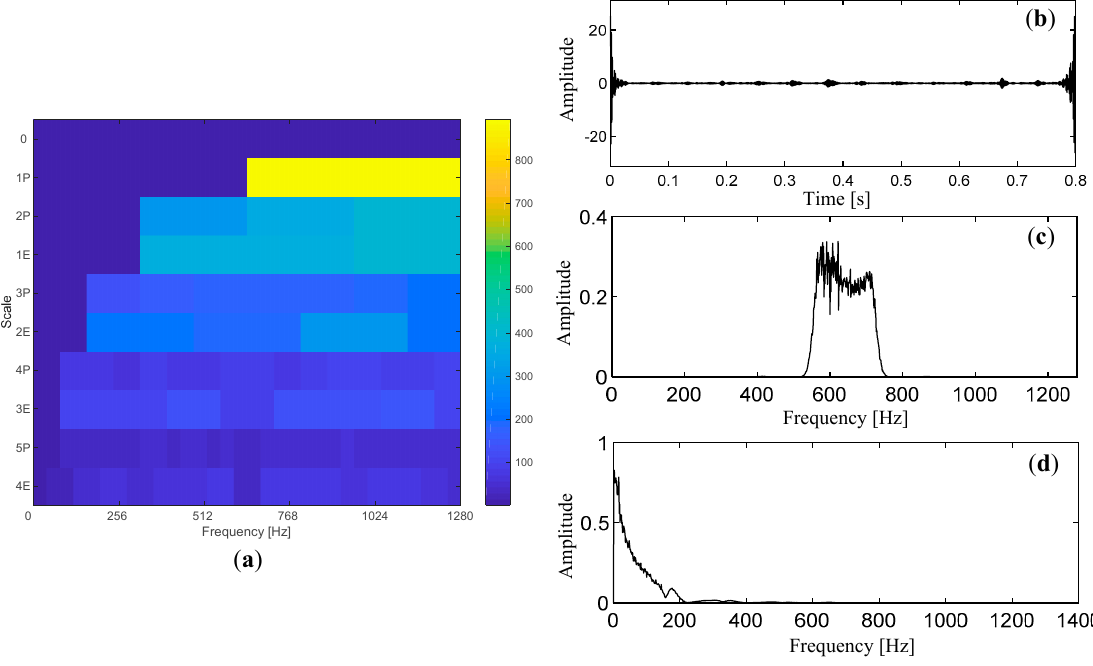
Figure 36. Analysis results of the displacement signal by wavelet decomposition: ( a ) distribution of kurtosis of each wavelet subspaces; ( b ) time domain waveform of iwp 4,4 ( n ) ; ( c ) Fourier spectrum of iwp 4,4 ( n ) ; and ( d ) Hilbert envelope spectrum of iwp 4,4 ( n ) .